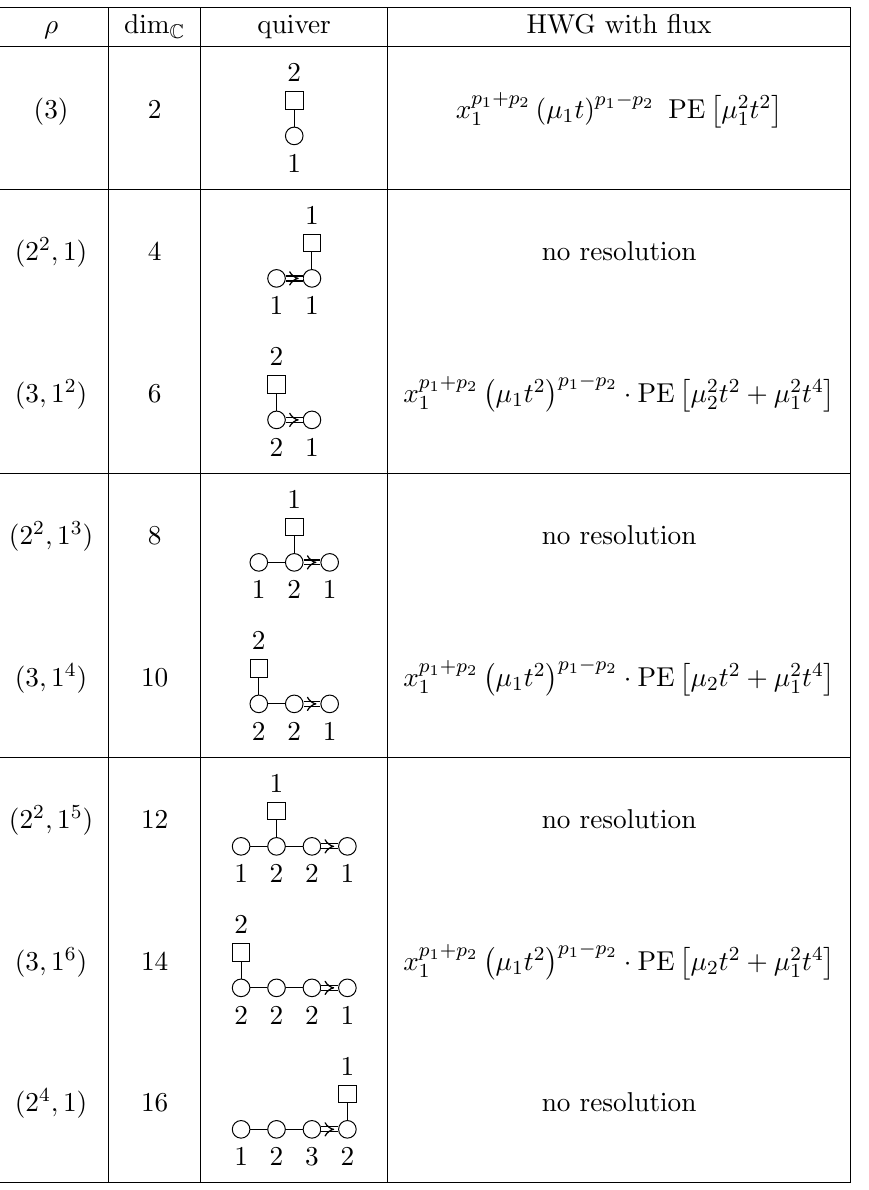
Table 4 . Coulomb branch quiver gauge theories for B -type algebras: realisations of the (clo- sures of the) nilpotent orbits of height 2 for B n with n = 1 ; 2 ; 3 ; 4. The unphysical U(1) in G F can be eliminated as before: introducing an auxiliary fugacity z 0 for U(1) (cid:26) G F , and imposing P Q n j p j z z r i = 1, with r i the ranks of the gauge nodes, leads to x 1 = 1 for (3 ; 1 2 n (cid:0) 2 ) (and 0 i i =1 z 0 (cid:17) 1). This is morally equivalent to setting the sum of (cid:13)uxes to zero in the